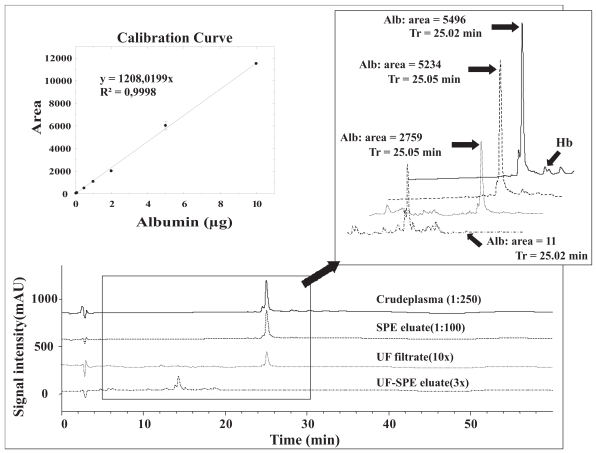
Representative UV-chromatograms of 50 μL of either diluted or concentrated samples. See Figure 1 legends for details regarding the SPE, UF and UF-SPE protocols. UV absorbance detection was set at 214 nm. A calibration curve was constructed using HSA for the determination of albumin (Alb) quantity in crude plasma, SPE eluates, UF filtrates and UF-SPE eluates. Error bars indicate the relative standard error for each sample run in duplicate. Full range and expanded chromatograms of all four samples are shown at the same scale. Integrated areas and retention time of albumin are given. UV peaks corresponding to haemoglobin (Hb) are also shown.